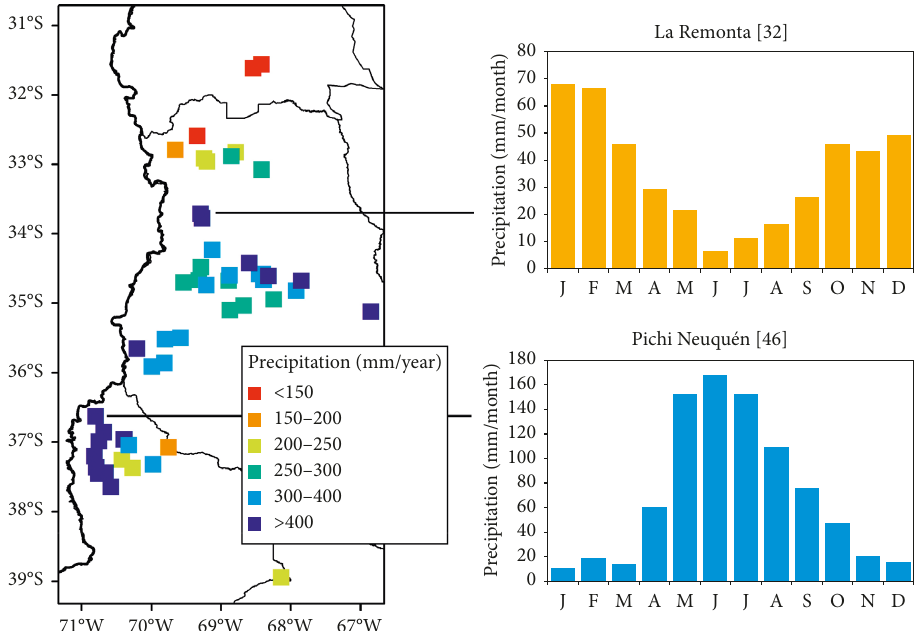
Figure 2: Spatial distribution of the mean annual precipitation over the study area, together with the annual precipitation cycle at two reference